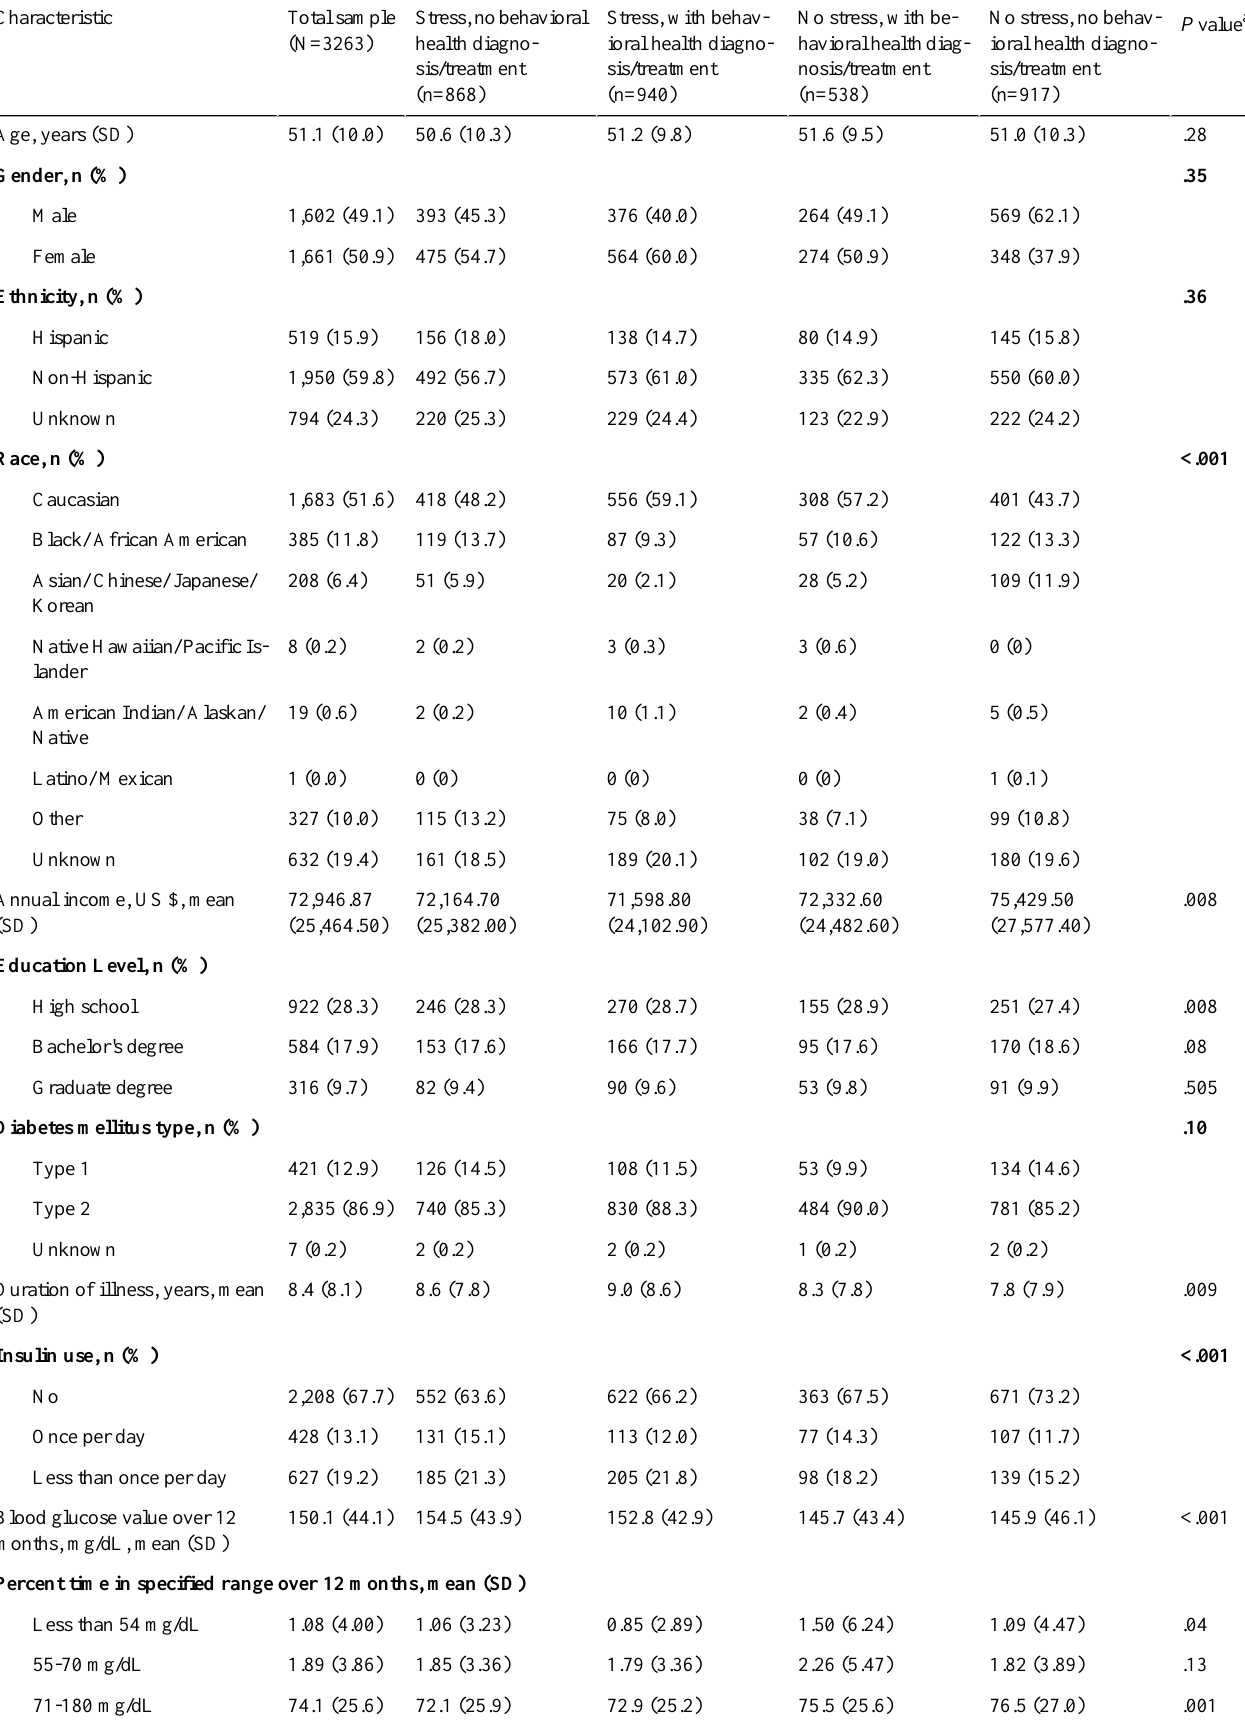
Table 1. Participant demographics and characteristics.